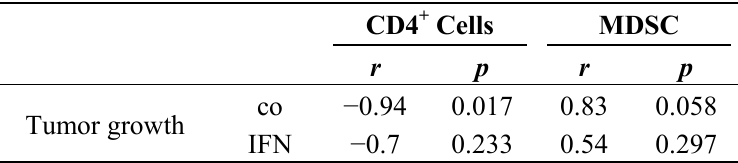
Table 2. Spearman correlation of values CD4 + cells and MDSC (myeloid-derived suppressor cells) against tumor